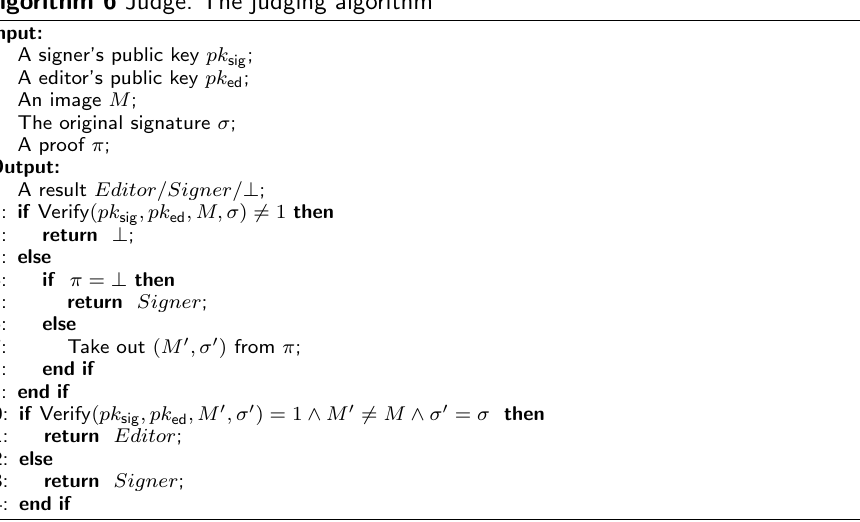
Algorithm 6 Judge: The judging algorithm